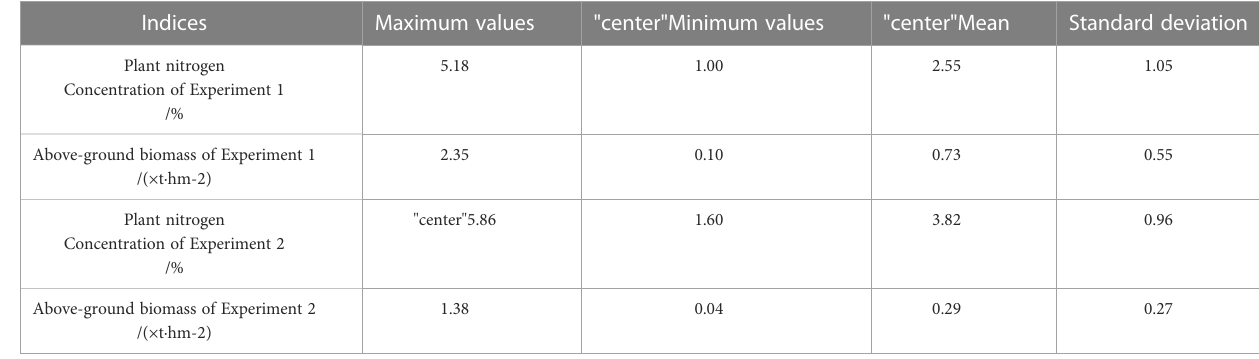
TABLE 1 Plant N concentration and AGB